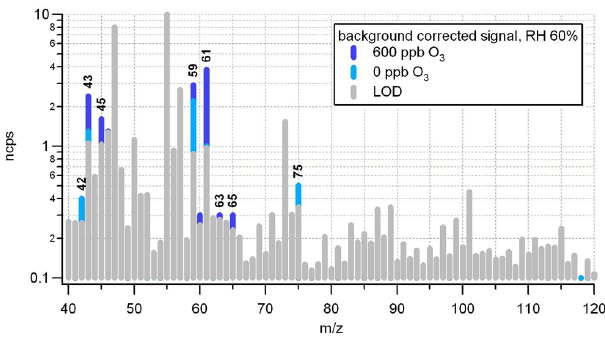
Figure 5. Comparison of mass spectra of the background VOC in the CLOUD chamber during CLOUD1. All spectra are averaged for 2h and background-corrected. The grey bars at the bottom of individual mass fragments are the associated LOD.